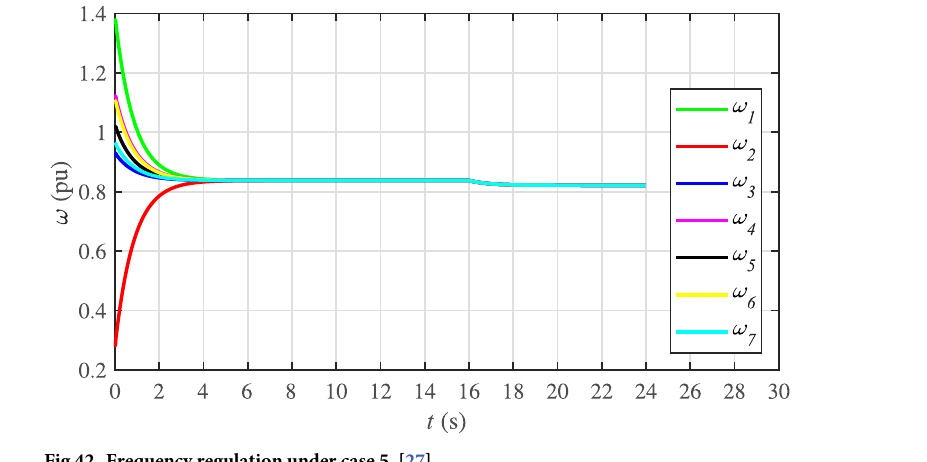
Fig 42. Frequency regulation under case 5. [27].